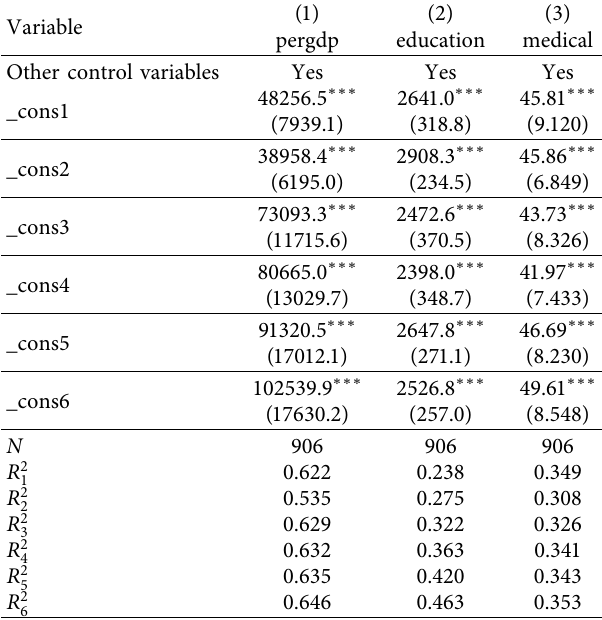
Table 3: DID dynamics test results of TCID on economic growth and public service